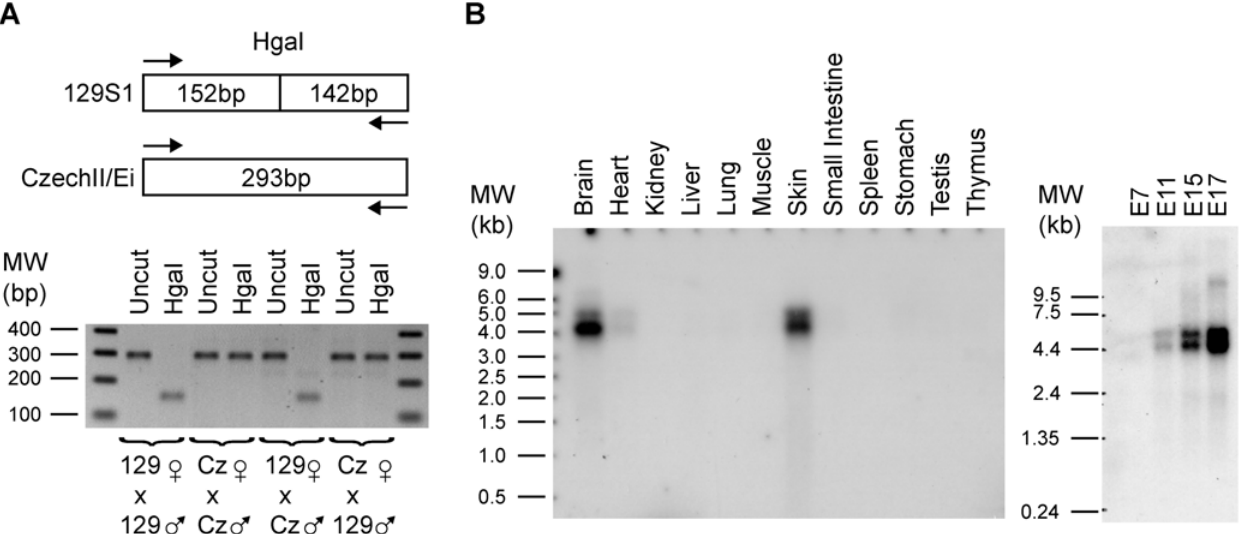
Figure 6. Meg8 is expressed from the maternal allele and highly in the brain and skin. (A) The Meg8 alleles contain an informative restriction site polymorphism in that a HgaI site is present in the 129S1 allele in comparison to CzechII/Ei. RT-PCR products with AF498299 1Up/294Dn primers for Meg8 from the four intraspecific crosses were digested with and without HgaI, verifying the imprinted expression of this gene. (B) Northern blots were performed on adult tissues (left) and embryos harvested at different time points (right). Meg8 levels were highest in brain and testis. In addition, Meg8 RNA increases as a functional of embryonic development.